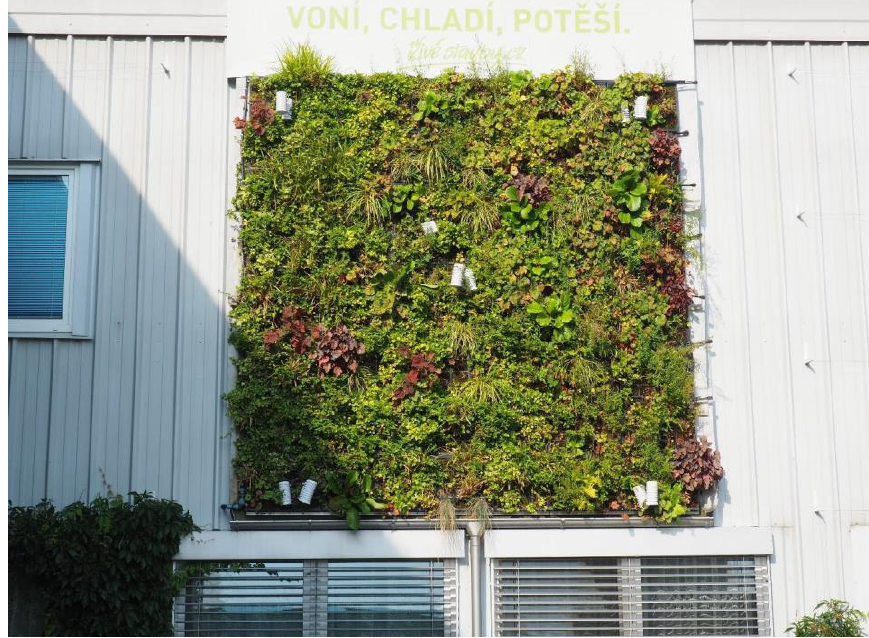
Figure 1. View of the model LW in the LIKO-S company (the text above the LW means: “it smells good, it cool, it gives pleasure”). Author: Adéla Br ázdová (07/2021). LW is located in Slavkov u Brna in the South Moravian Region in the Czech Republic.